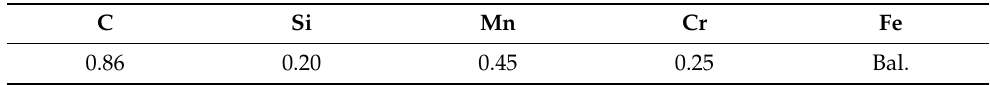
Table 1. The chemical composition of the SK85 steel (wt.%).